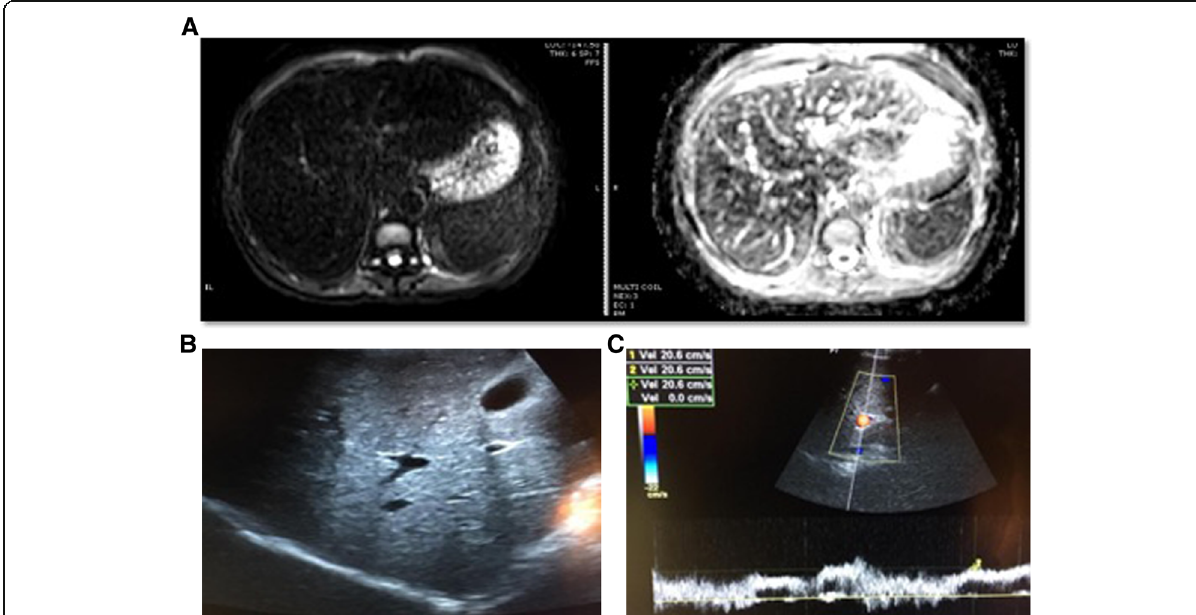
Fig. 5 a 35 years old HCV positive female patient, underwent Fibroscan with 6 kPa which was classified as F1 stage (F1=5-7 kPa), His diffusion study: reveals mildly enlarged liver with no focal lesions. The spleen was of average size with no focal lesions ( a )-DWI at b = 800- and ( b )-ADC map, revealed mean liver ADC = 0.95 × 10 − 3 mm2/s and spleen mean ADC = 0.66× 10 − 3 mm2/s so normalized ADC= 1.45(F1 nADC cut off = 1.44). b & c -His ultrasound study reveals ( b )-mild hepatomegaly (16 cm) with no cirrhotic features or focal lesions and ( c )-portal vein shows average calibre with the hepatopedal flow( numbering adjusted)